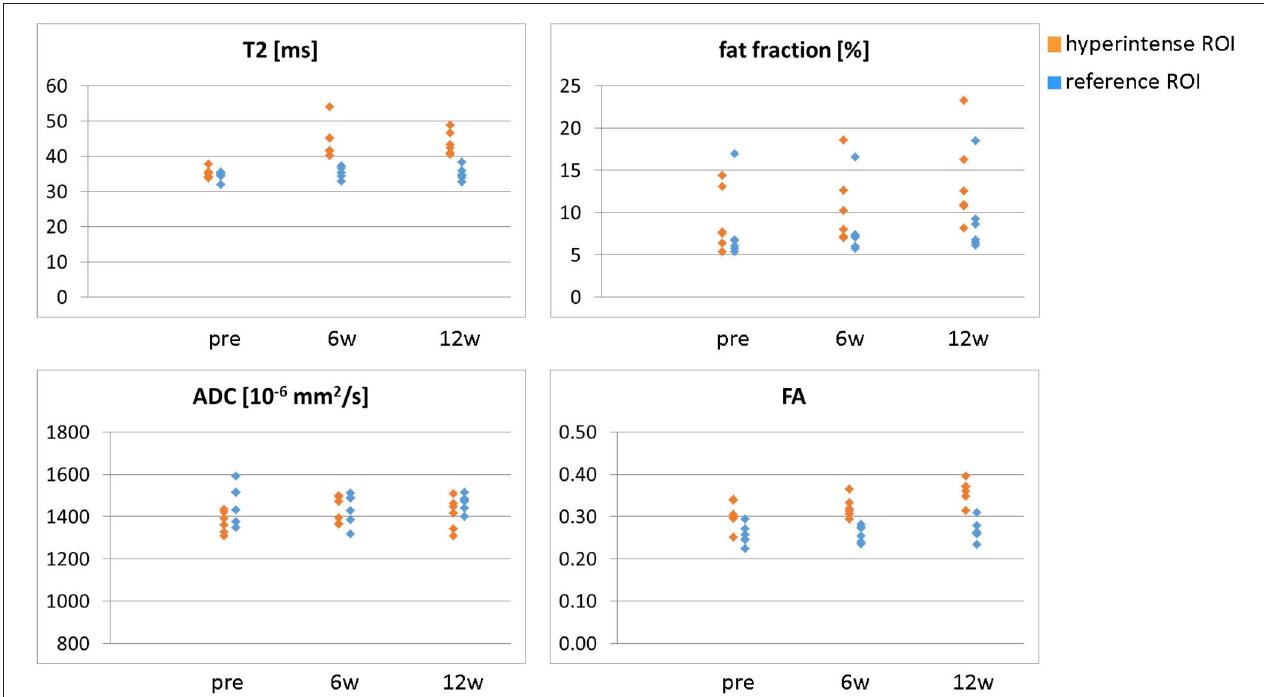
FIGURE 4 | Overview of all ROI mean values (T 2 , fat fraction, ADC, and FA) in the hyperintense (orange) and reference ROIs (blue) for all six patients at time points pre-BTX, 6 weeks (6w), and 12 weeks (12w) post-BTX. ROI, region of interest; BTX, botulinum toxin A; ADC, apparent diffusion coefficient; FA, fractional anisotropy.